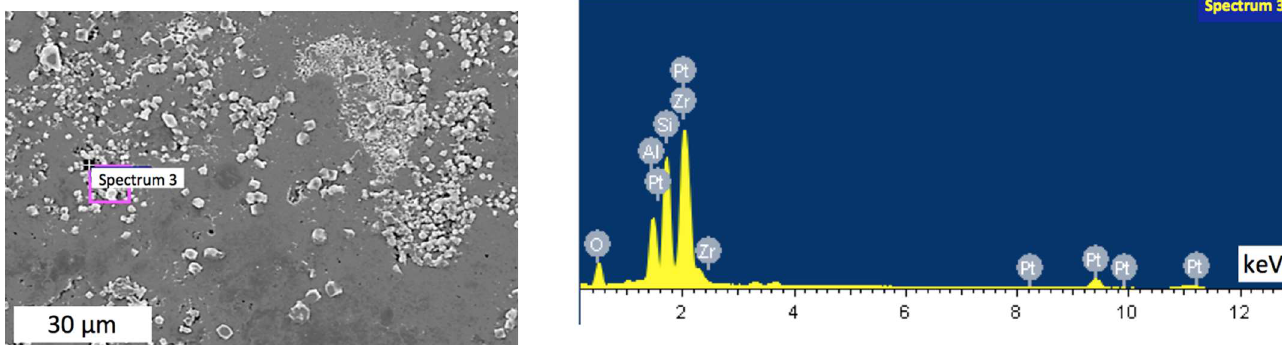
Figure 9. Elemental analysis in point 3 of the sample #4. Table 3. Elemental proportions in point 3 of the sample #4.